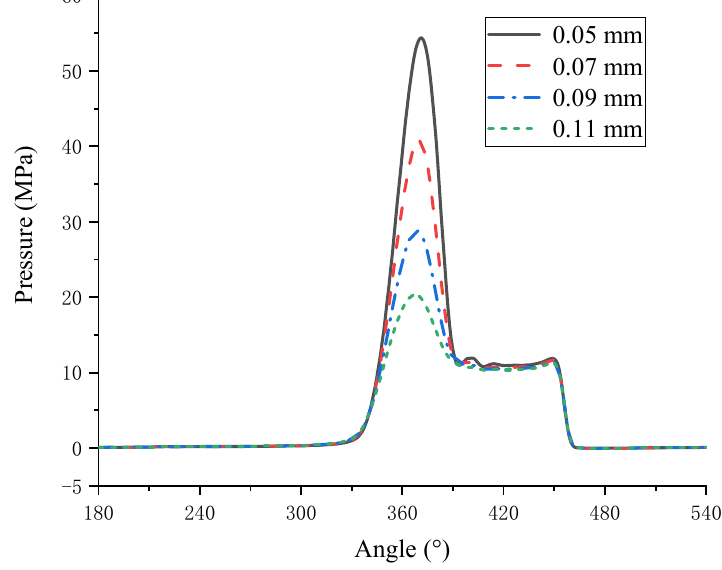
Figure 17. The pressure of P2 at different axial clearances. It can be seen from Table 3 that the maximum pressure decreases by 19.3 MPa, and the volumetric efficiency decreases by 4.1% when the rotating speed decreases from 2900 r/min to 1400 r/min. When the axial clearance increases from 0.05 mm to 0.11 mm, the maximum pressure decreases by 34.1 MPa, and the volumetric efficiency decreases by 20.3%. There- fore, the pressure pulsation in the working chamber can be improved to a certain extent by reducing the rotating speed and increasing the axial